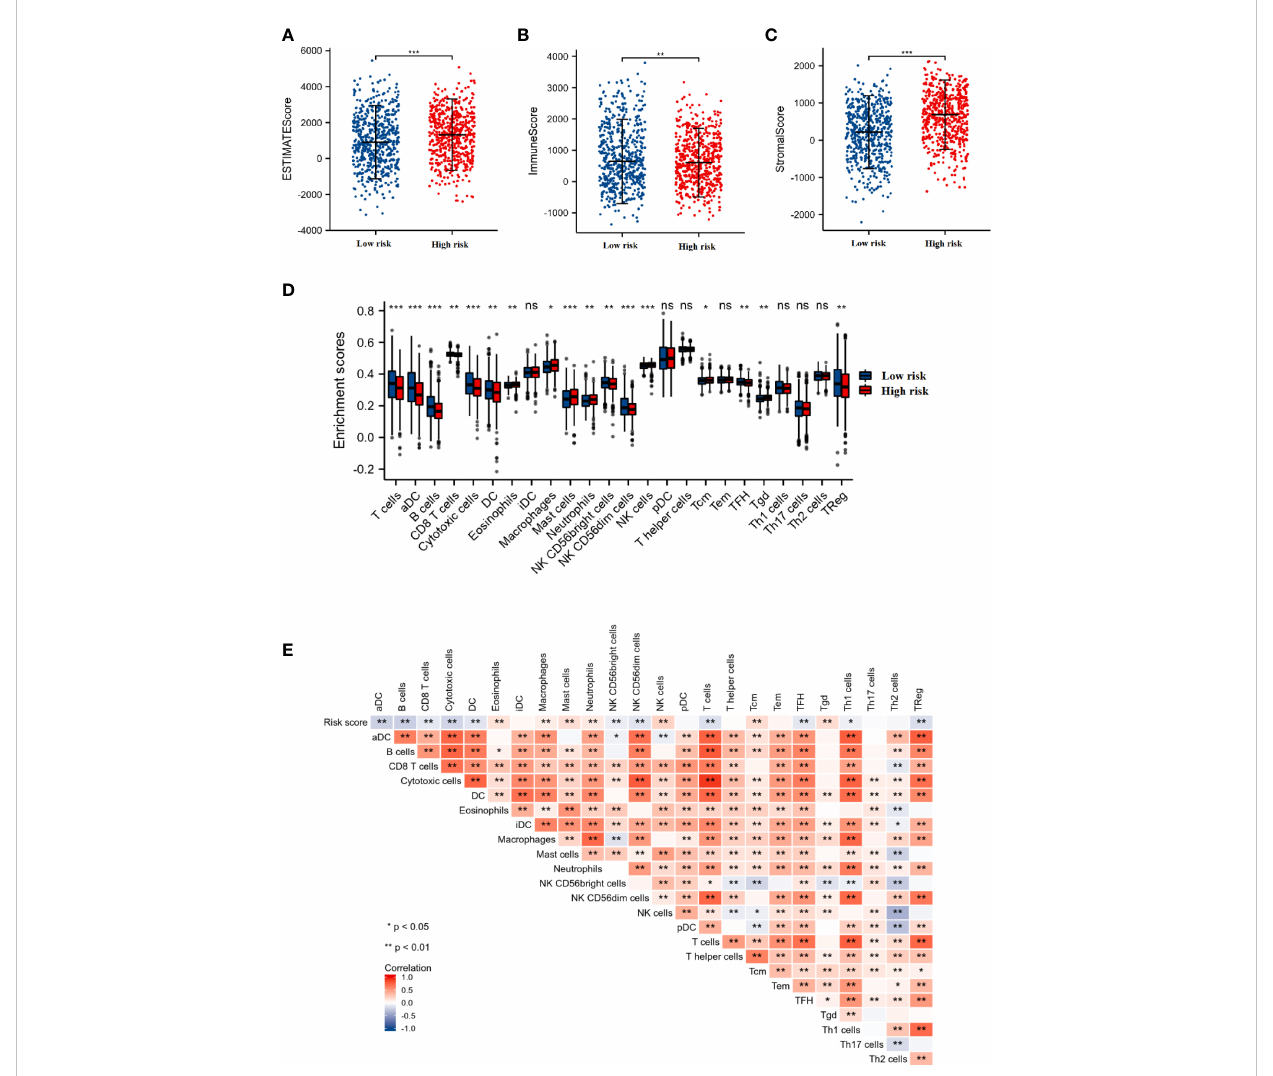
FIGURE 4 The association between the immune status and risk score. The comparison of ESTIMATE score (A) , Immune score (B) , and Stromal score (C) between the low- and high-risk score groups. (D) The box plot presented the differences in immune cell in fi ltration between the low- and high-risk score groups. (E) Correlation analysis of the risk score and immune cell in fi ltration in breast cancer. *p < 0.05, **p < 0.01, ***p < 0.001. "ns" is no signi fi cant